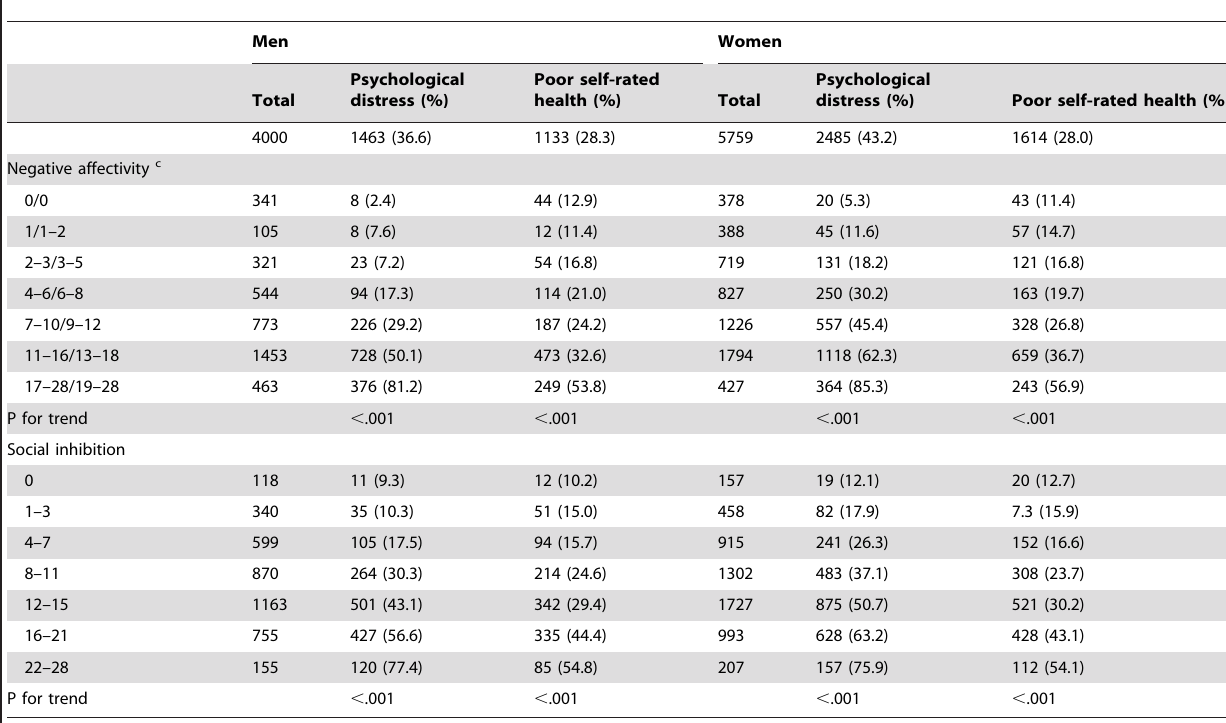
Table 2. Distribution of psychological distress a and poor self-rated health b by levels of Type D subscales, Japan, 2010.